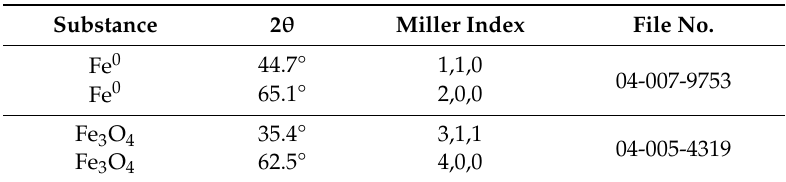
Figure 6. PXRD di ff ractograms. Blank@ORMOSIL-black, 1.0 M ZVI ethanolic suspension—blue, Table 1. Metal phases found in ZVI@ORMOSIL.